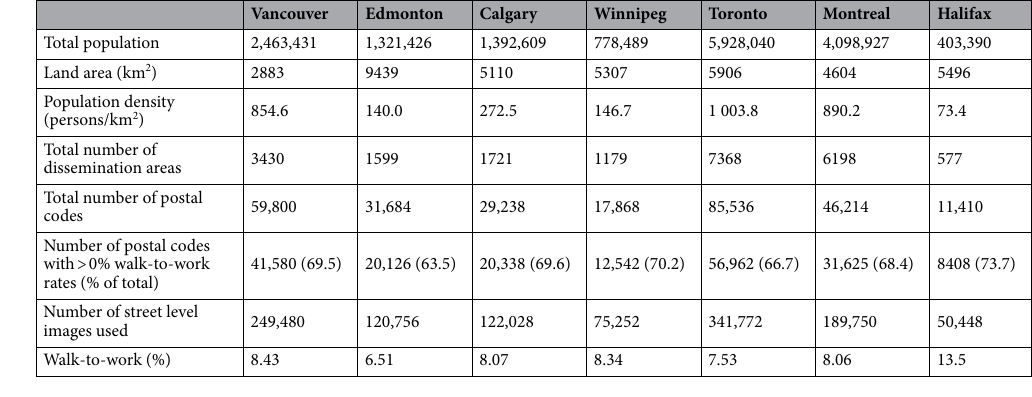
Table 1. Population, area, population density, number of census tracts, and number of street-level